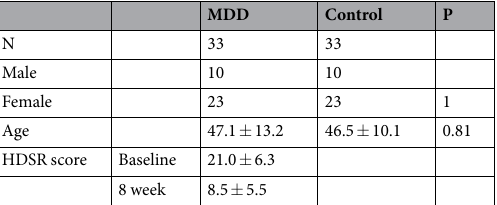
Table 1. Demographic of participants. MDD: major depressive disorder; HDRS: Hamilton Depression Rating